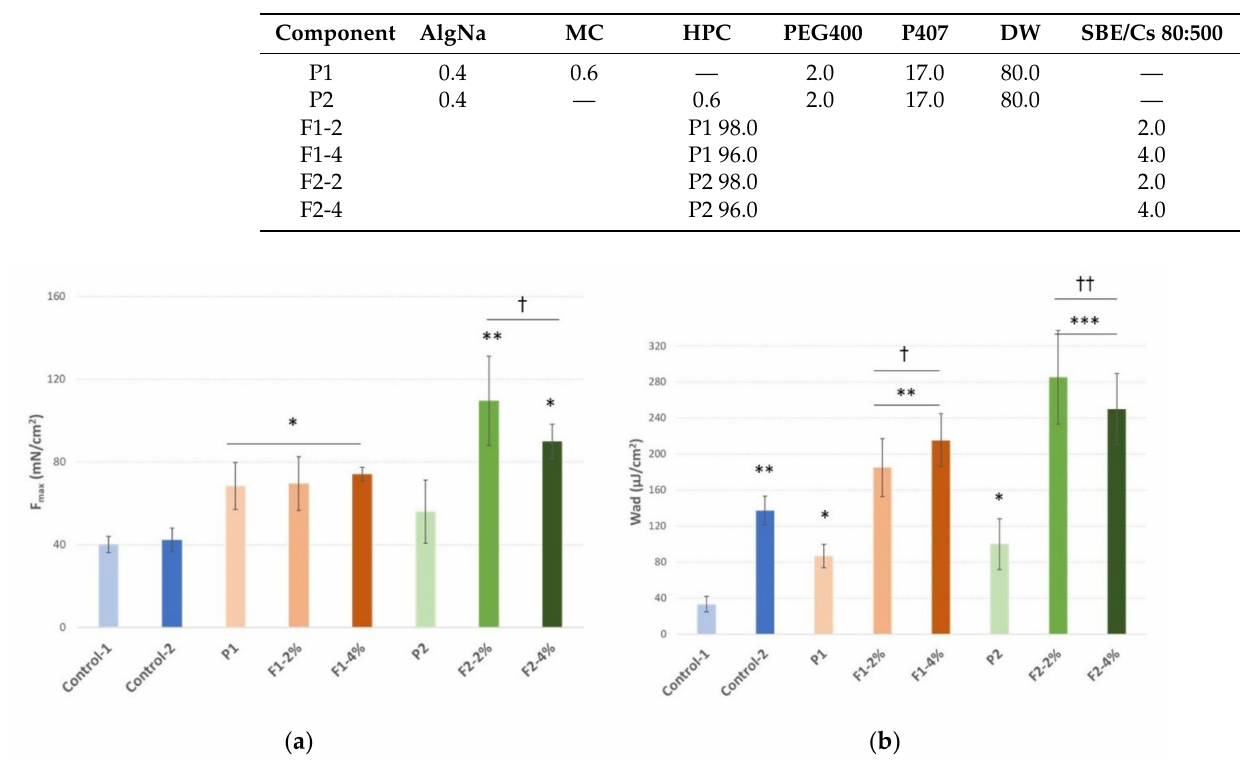
Figure 7. ( a ) Maximum detachment force (F max ) expressed in millinewtons (mN); ( b ) work of mucoadhesion (W ad ) expressed in microjoules per tissue area unit ( µ J/cm 2 ) of hydrogels with a binary mixture of lyophilized extract of S. baicalensis radix and chitosan 80:500 (in weight ratio 1:1) (F1–F2), placebo formulations (P1–P2), and controls (Control-1 cellulose paper; Control-2 commercial oromucosal gel) in contact with excised porcine cheek (mean ± S.D., n = 5); * represents substantial differences with p ≤ 0.05, ** with p ≤ 0.01 and *** with p ≤ 0.001 in comparison to Control-1; † and †† symbolize significant differences with p ≤ 0.05 and p ≤ 0.01 in comparison to placebo